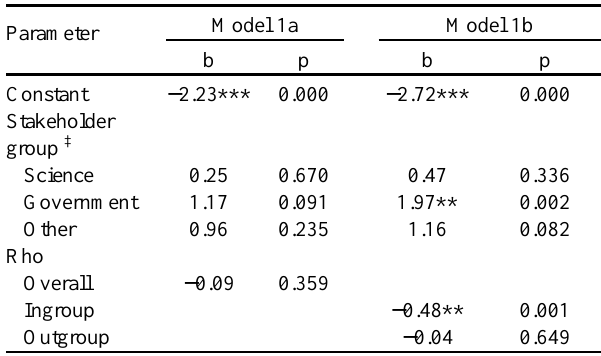
Table 2 . Network autocorrelation results for one statement: unstandardized regression coefficients and p values. † Model